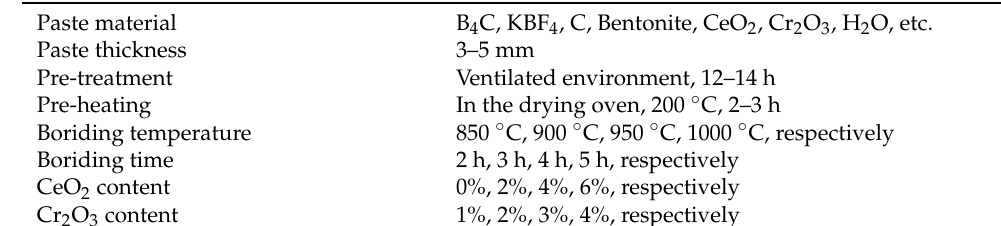
Table 2. Experimental parameters.